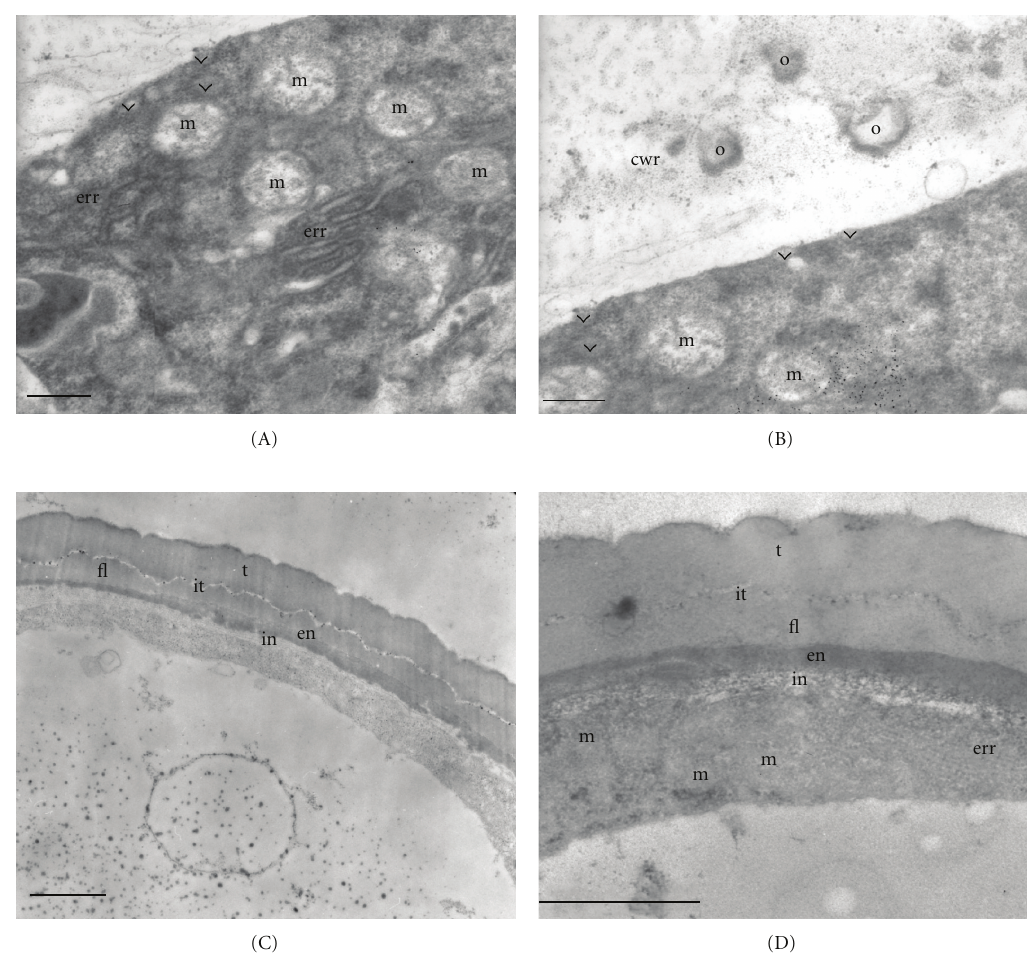
Figure 3: Stage 3: free microspores. Colletia paradoxa. (A) Tapetal cell with proorbicules (arrow head), many mitochondria (m), and rough endoplamic reticulum (err). (B) Details of tapetal cell, wall degraded, and orbicules are observed between its remains (cwr: cell wall remains). Mitochondria (m) and proorbicules (arrow head) are also observed. (C) Young microspore: intine (in), endexine (en), foot layer (fl), a tectum (t), and a granular infratectum (it) are clearly distinguished. (D) Details of the young microspore cytoplasm with mitochondria (m) and endoplasmic reticulum of tough type (err). Scale bar: (A) 280 nm; (B) 300 nm; (C)-(D) 1.3 µ